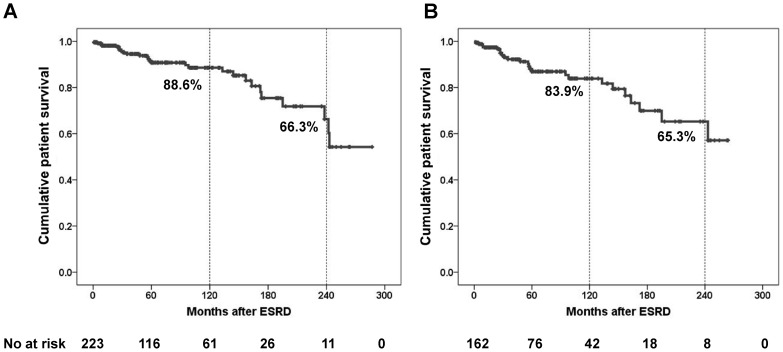
Cumulative patient survival after ESRD progression according to the all ESRD patients(A) and excluding transplantation recipients (B). The primary outcome is patient survival. The numbers of patients remaining at 60, 120, 180, 240, 300, and 360 months of follow-up are shown at the bottom. ESRD, end stage renal disease.